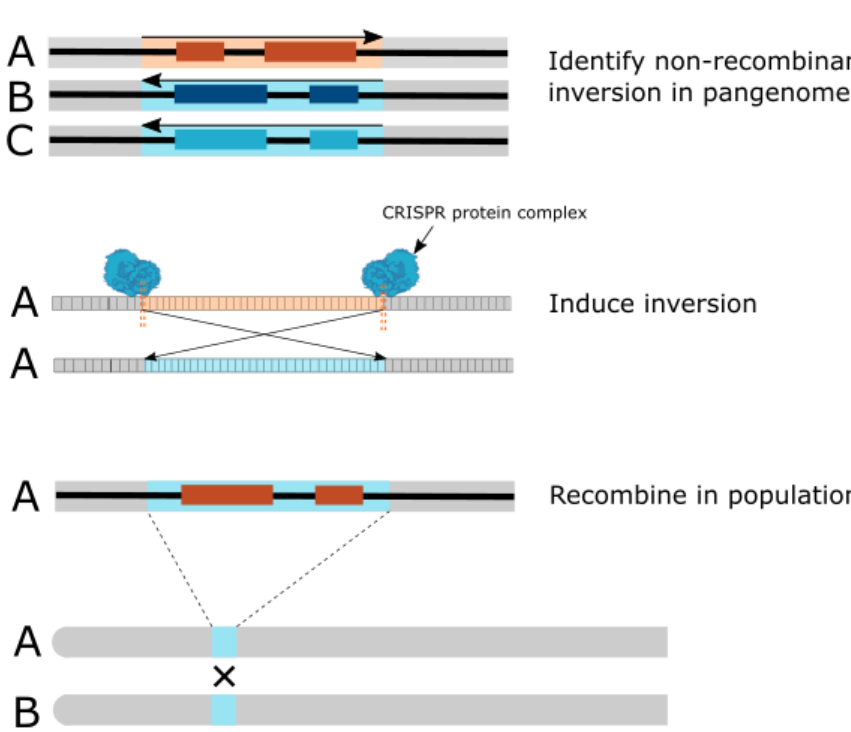
Figure 3. Reversal of inversion through CRISPR to allow crossing of inverted genes. A pangenome is used to identify a non-recombinant inversion in individual A compared to individuals B and C. CRISPR-Cas proteins are then used to induce double-stranded breaks at specific target sites in the inverted region, leading to re-inversion of the genomic segment and accessibility of the locked genes for recombination. The previously inverted genes in individual A can then be crossed with other individuals in the population.